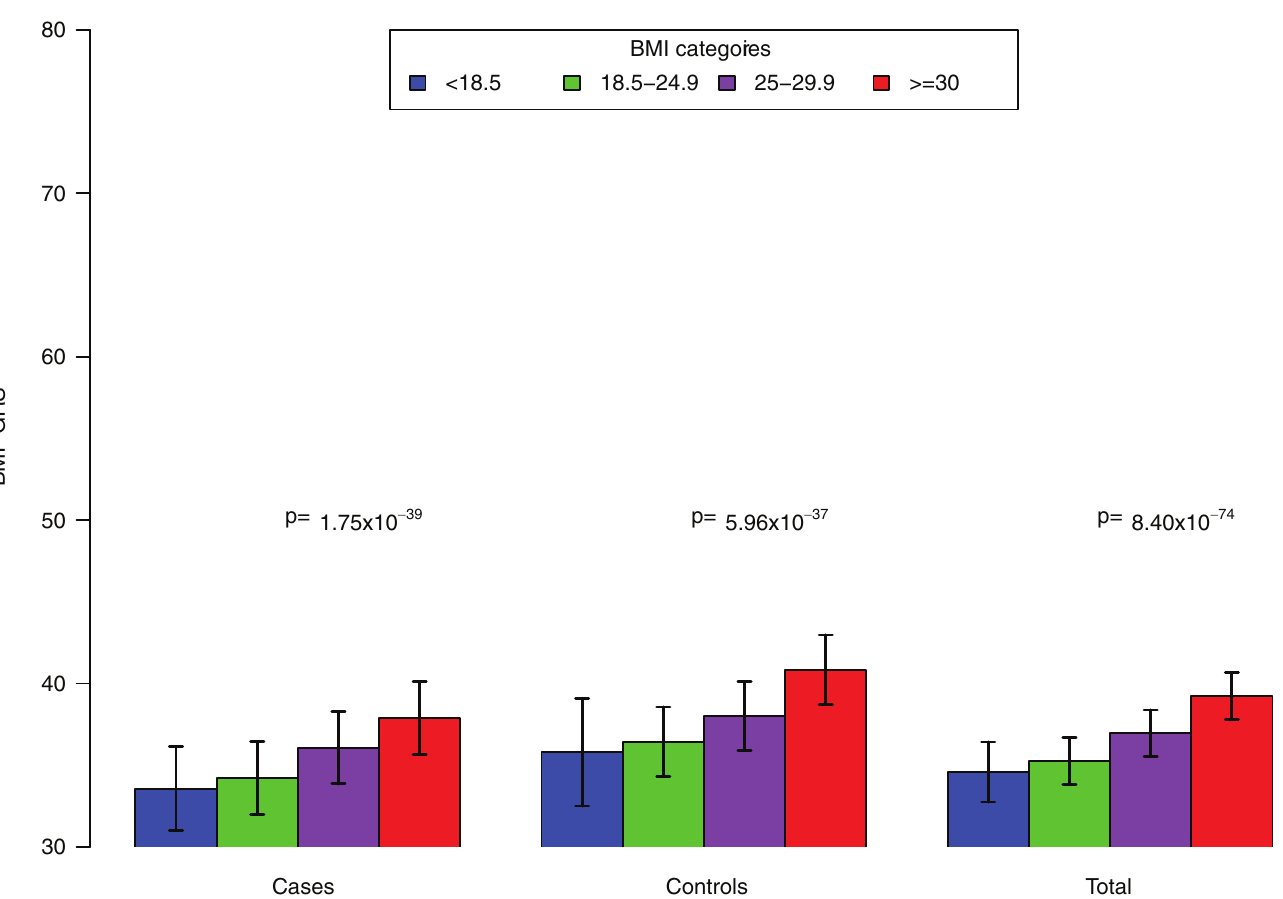
Fig 3. Adjusted means of the BMI-GRS (95% CIs) by BMI category after adjustment for age, sex, study sites, genetic principal components, smoking status, and pack-years of smoking. Bar represents mean ± s.d.